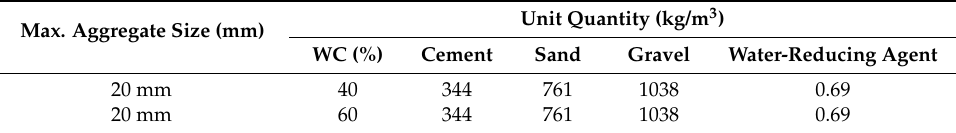
Table 1. Design mix of